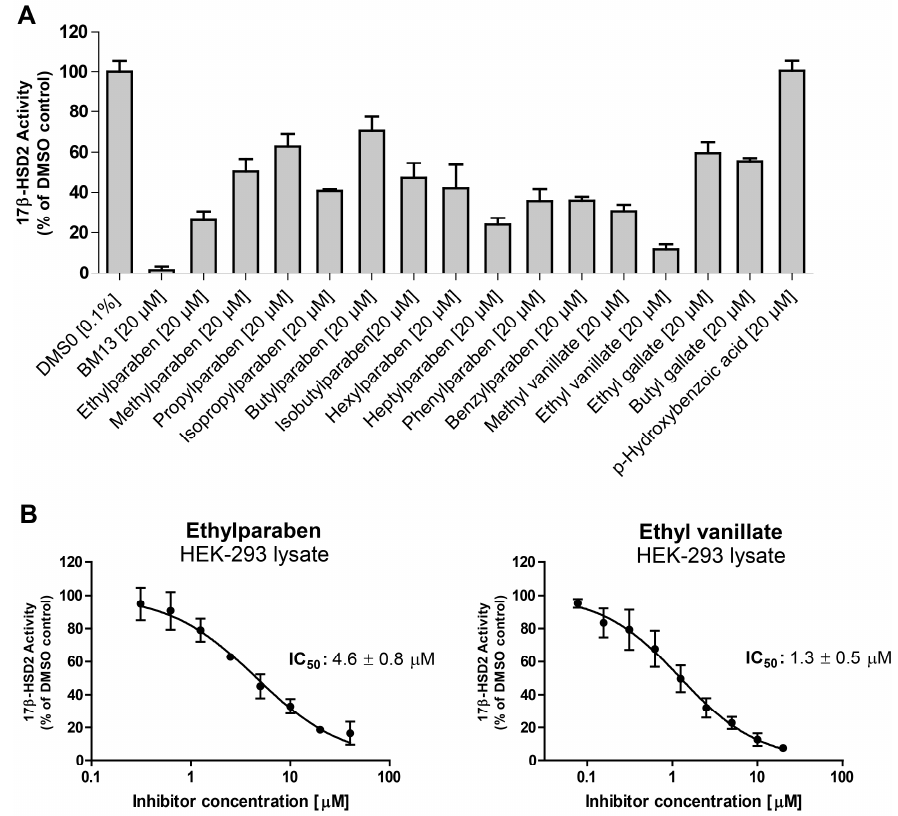
Figure 4. ( A ) Inhibition of estrone formation by parabens in human embryonic kidney (HEK-293) cell lysates expressing human 17 β -HSD2. The conversion of estradiol to estrone was measured in lysates of HEK-293 cells transiently transfected with 17 β -HSD2 in the presence of 200 nM radiolabeled estradiol and parabens or paraben-like compounds at a final concentration of 20 µ M. 17 β -HSD2 inhibitor BM13 served as positive control (compound 22 in [18]). Statistical analyses were performed using one-way analysis of variance (ANOVA) test followed by a Dunnett post-hoc test. All tested compounds significantly inhibited 17 β -HSD2 activity ( p ≤ 0.001) expect for p -hydroxybenzoic acid, which was not significant. ( B ) Concentration-dependent inhibition of 17 β -HSD2 by ethylparaben and ethyl vanillate. Results represent the mean ± standard deviation (SD) of three independent measurements.